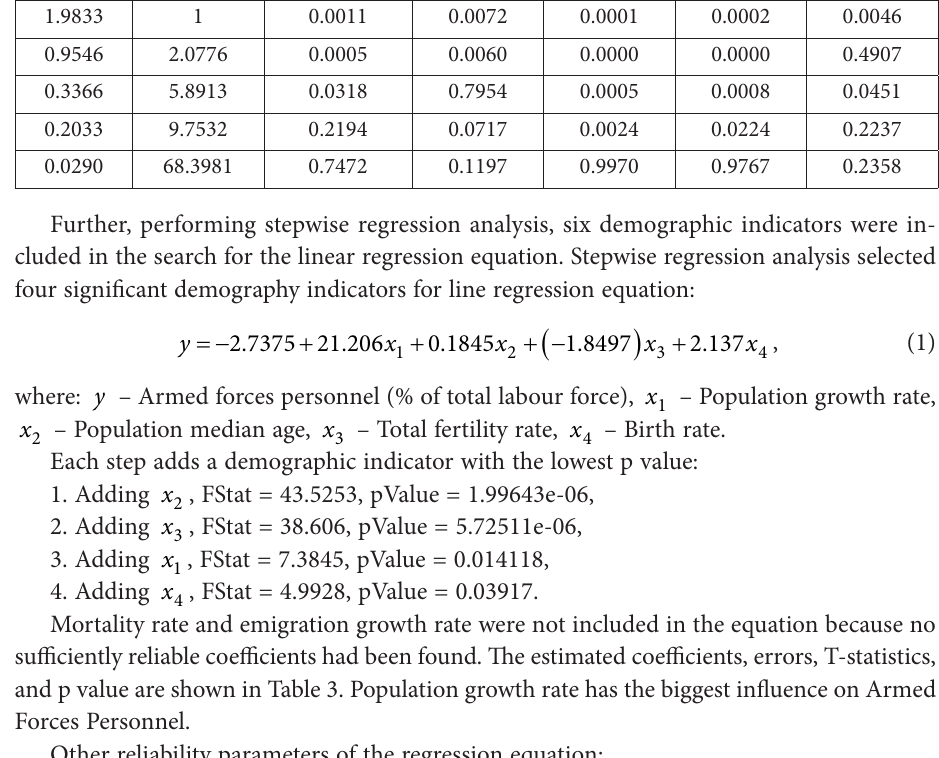
Table 2. Belsley collinearity diagnostics Condition Armed forces sValue indices